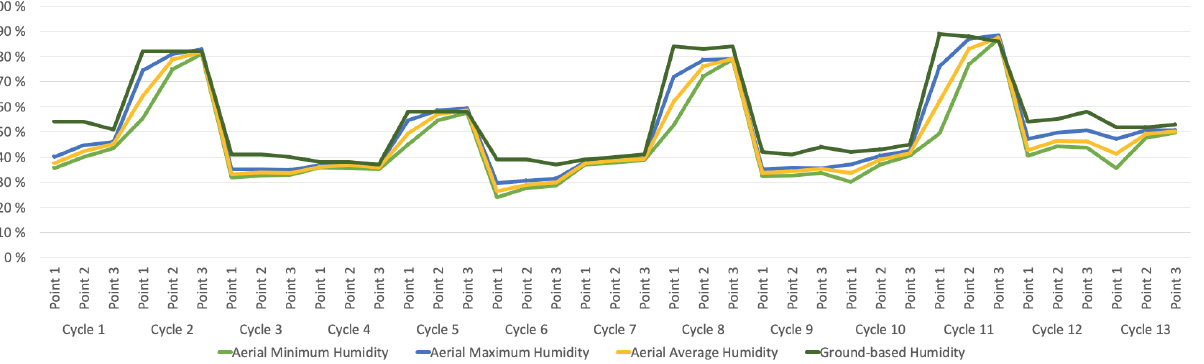
Figure 6. Aerial minimum, average, and maximum humidity compared with ground-based